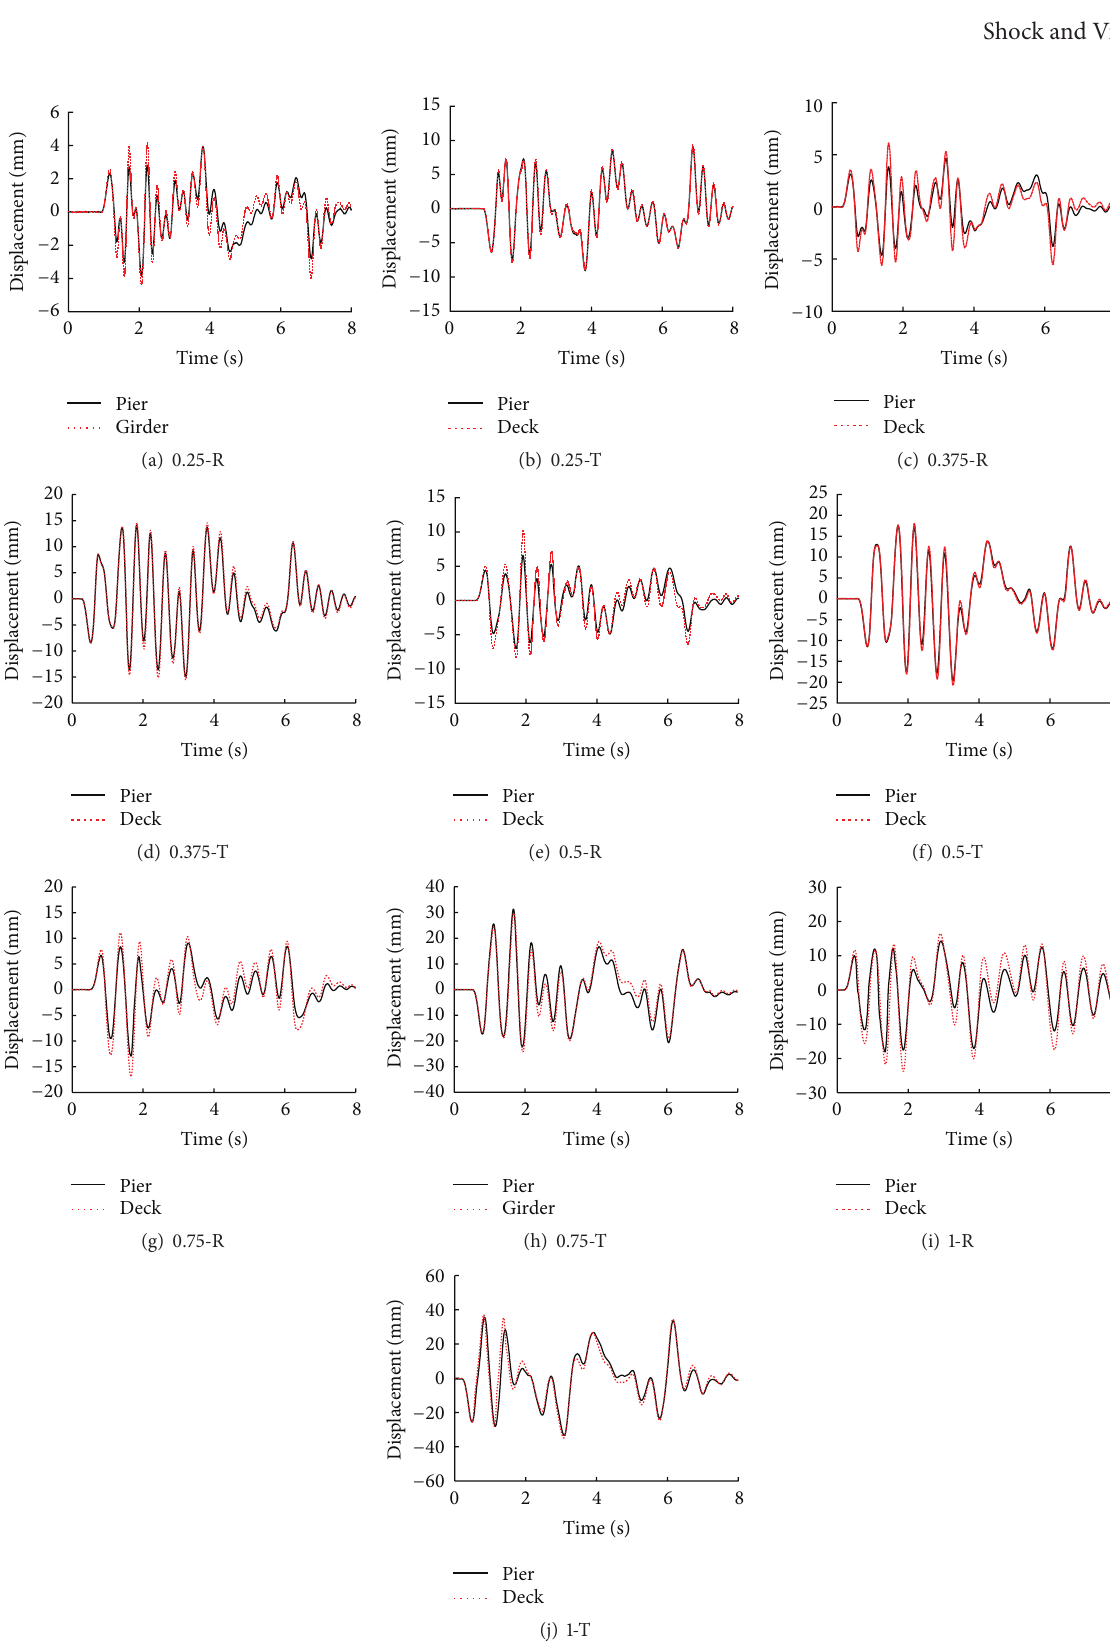
Figure 9: Comparison of time history curve of displacement. Note: 0.25-R stands for the radial displacement time history curves of pier top and girder when the input peak acceleration of seismic wave was 0.25 g PGA; 0.25-T stands for the tangential displacement time history curves of pier top and girder when the input peak acceleration of seismic wave was 0.25 g PGA and similar to other